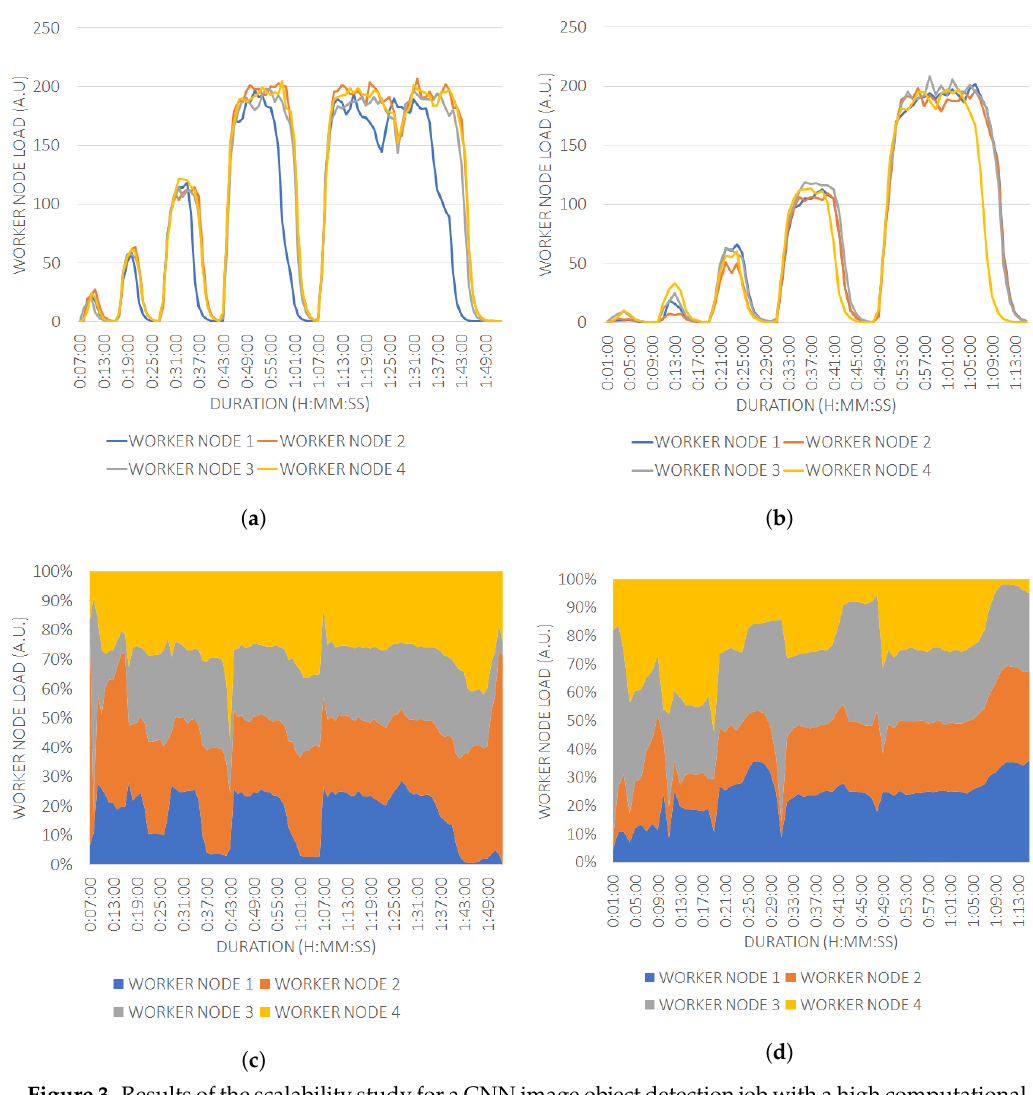
Figure 3. Results of the scalability study for a CNN image object detection job with a high computational requirement. Batches of 16, 32, 64, 128, and 256 simultaneous jobs were systematically tested. The charts represent the average CPU load on each worker node for a reference base cluster (4 worker nodes, 16 cores per node) and a horizontally scaled cluster (8 worker nodes, 16 cores per node). ( a , b ) represent the load in absolute value and ( c , d ) the value relative to 100% at every time, for the base cluster and the horizontally scaled cluster respectively in both